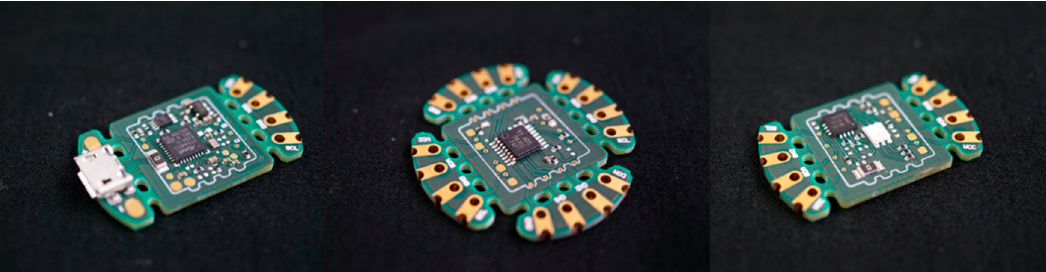
Figure 2. ( Left ) Main control unit. ( Middle ) ADC module. ( Right ) LED module.